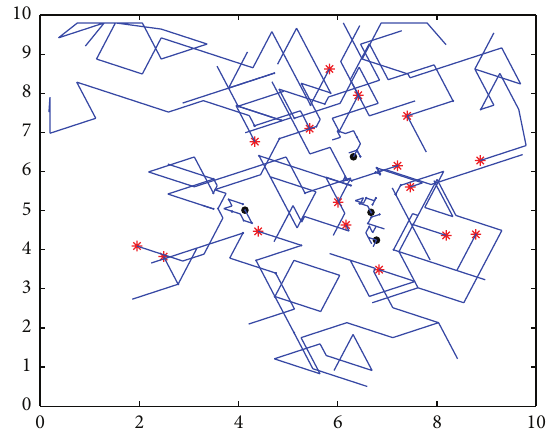
Figure 1: The initial stage of the evolution of cooperative hunting